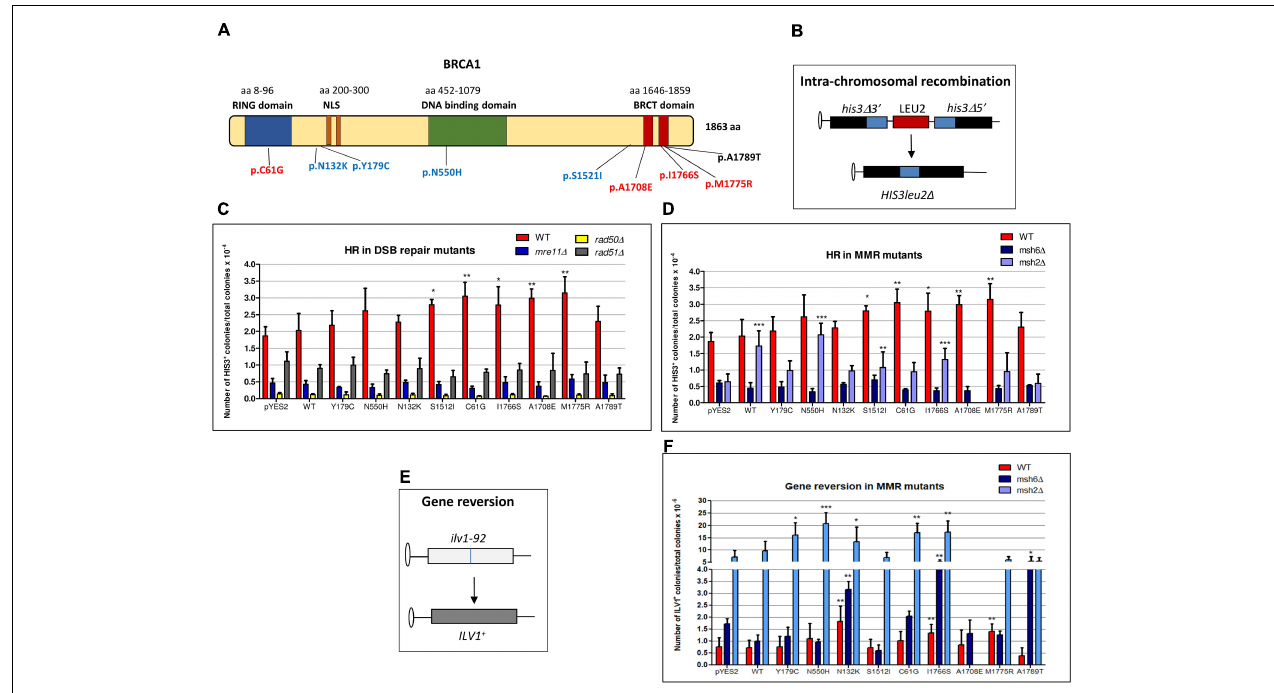
FIGURE 1 | Effect of BRCA1 pathogenic and neutral missense variants on intra-chromosomal recombination and gene reversion in Saccharomyces cerevisiae . (A) BRCA1 protein is composed by 1863 amino acids (aa) and consists of three main domains (RING, DNA binding, and BRCT domains) and a nuclear localization signal (NLS). Distribution of BRCA1 pathogenic (red), neutral (blue) variants, and VUS (black) tested in S. cerevisiae. The number of aa is reported above each functional domain. (B) The haploid strain RSY6 carries the two his3 alleles separated by the LEU2 marker and by the plasmid DNA sequence, one with a deletion